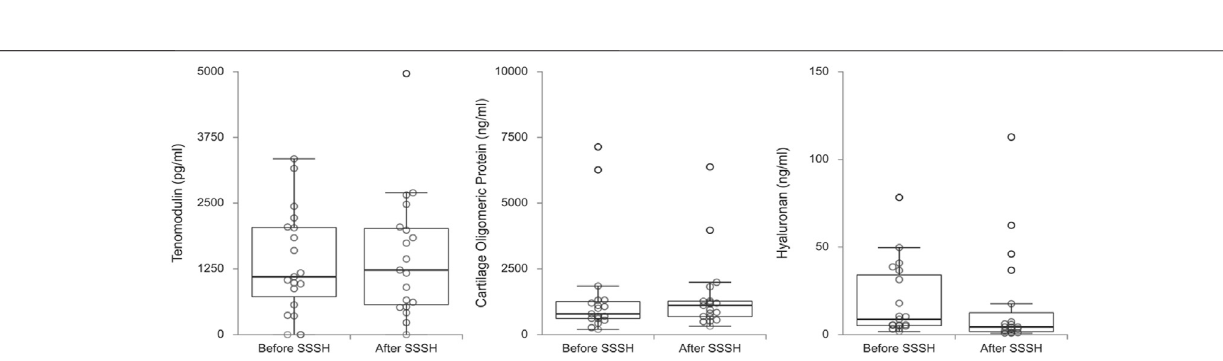
Frontiers in Aging |